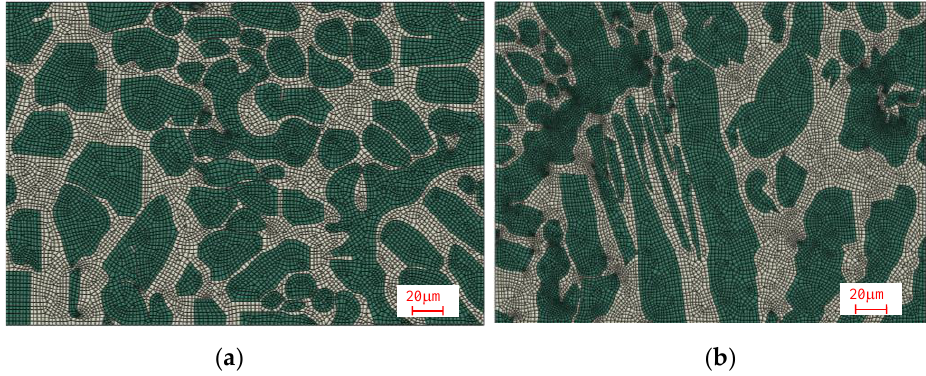
Figure 4. Geometric model and meshing of representative regions: ( a ) uniform area of grain ellipse (1#) and ( b ) vertically fenced area (2#).